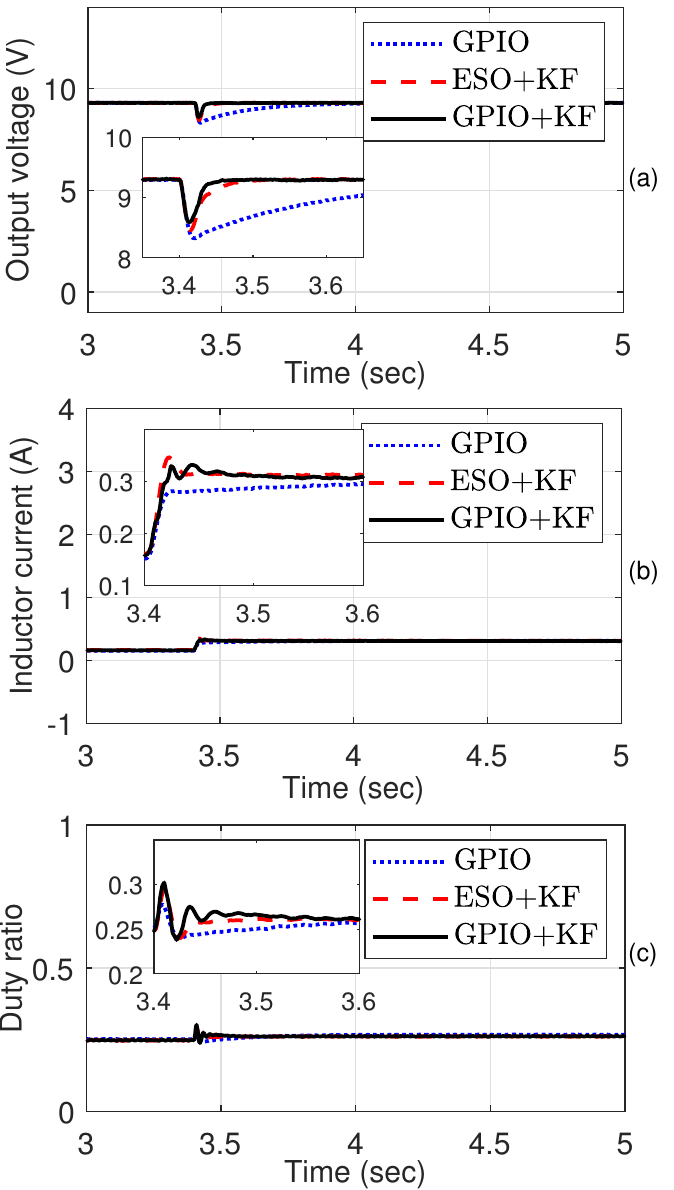
Figure 4. Waveform curves when disturbance is form of step. ( a ) Output voltage. ( b ) Inductor current. ( c ) Duty